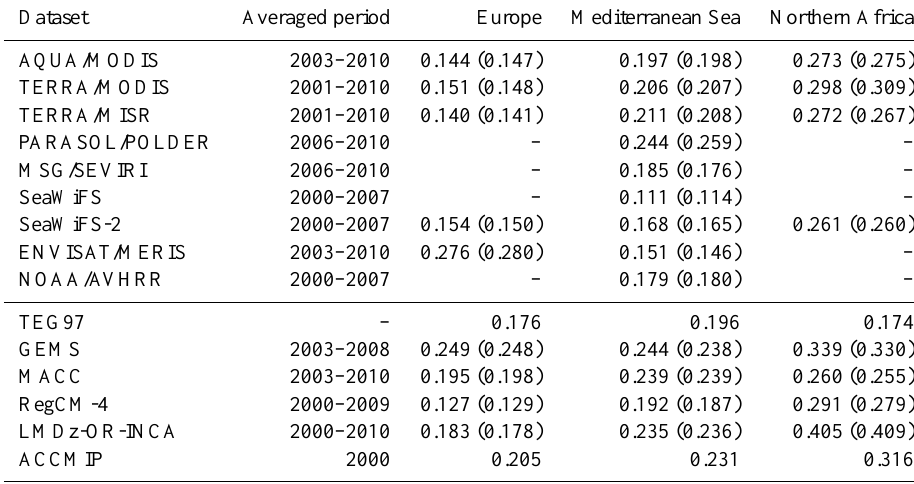
Table 3. Averaged AOD at 550nm over the European continent (region 8+9+10), the Mediterranean Sea (region 5+6) and Northern Africa (region 1+2) for each satellite-derived and model-simulated product. Averages are calculated over the period of study (second column) for each dataset. Averages over the 2006–2007 common period are also indicated (between brackets), except for TEG97 and ACCMIP which do not have interannual